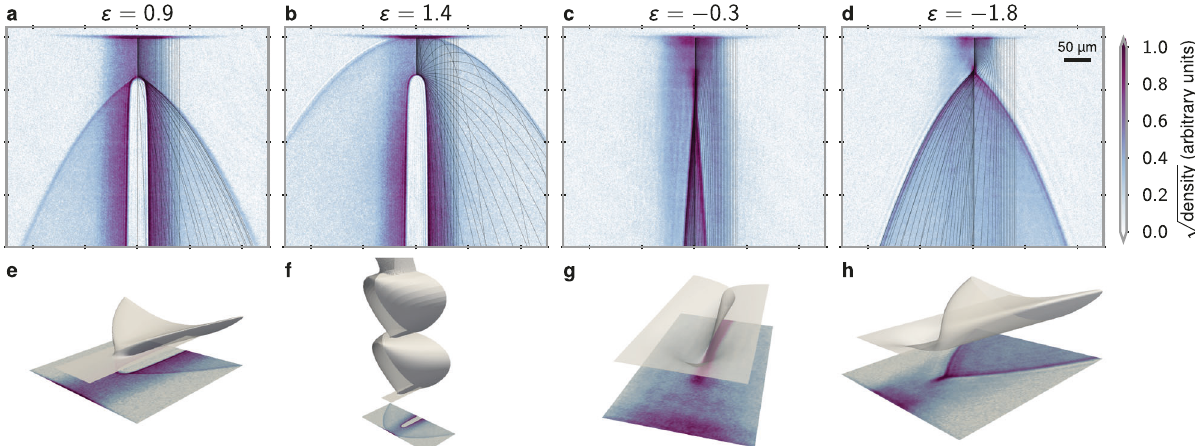
Fig. 4 Numerical simulation and visualization. a – d Numerical results of 50 trajectories from x i ∈ 0 – 80 μ m uniformly spaced in x 1 = 2 i to emphasize the scattering, overlaid on the experimental data. For clarity, a reversed color scheme has been used to plot the experimental images. e – h Corresponding map ffiffiffiffiffiffiffiffiffiffiffiffiffiffiffi p ð x ; t Þ 7!ð x ; z ; t (cid:2) (cid:2) 2 z = a Þ with the vertical time axis scaled by a factor of 5 for frame ( g ). These numerics are generated for a single repulsive ( a , b , e , f ) i i i z or attractive ( c , d , g , h ) potential with the energy ratio noted at the top of each